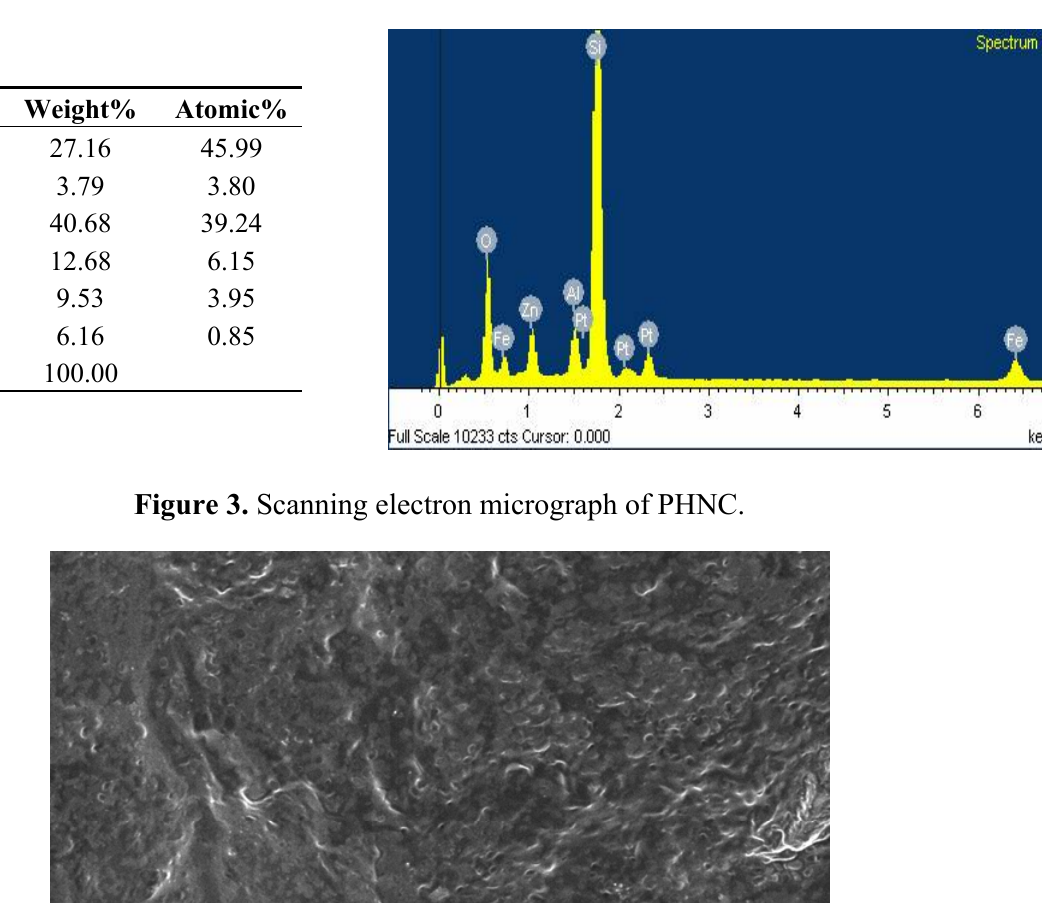
Figure 2. EDX spectrum of AlZnFe